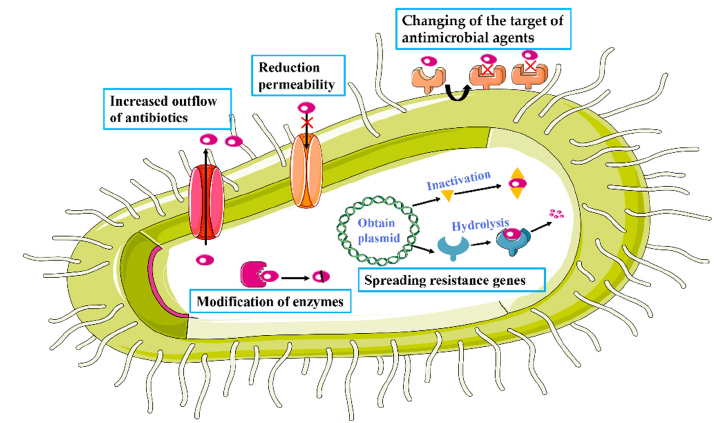
Figure 4. Mechanisms of antibiotic resistance.